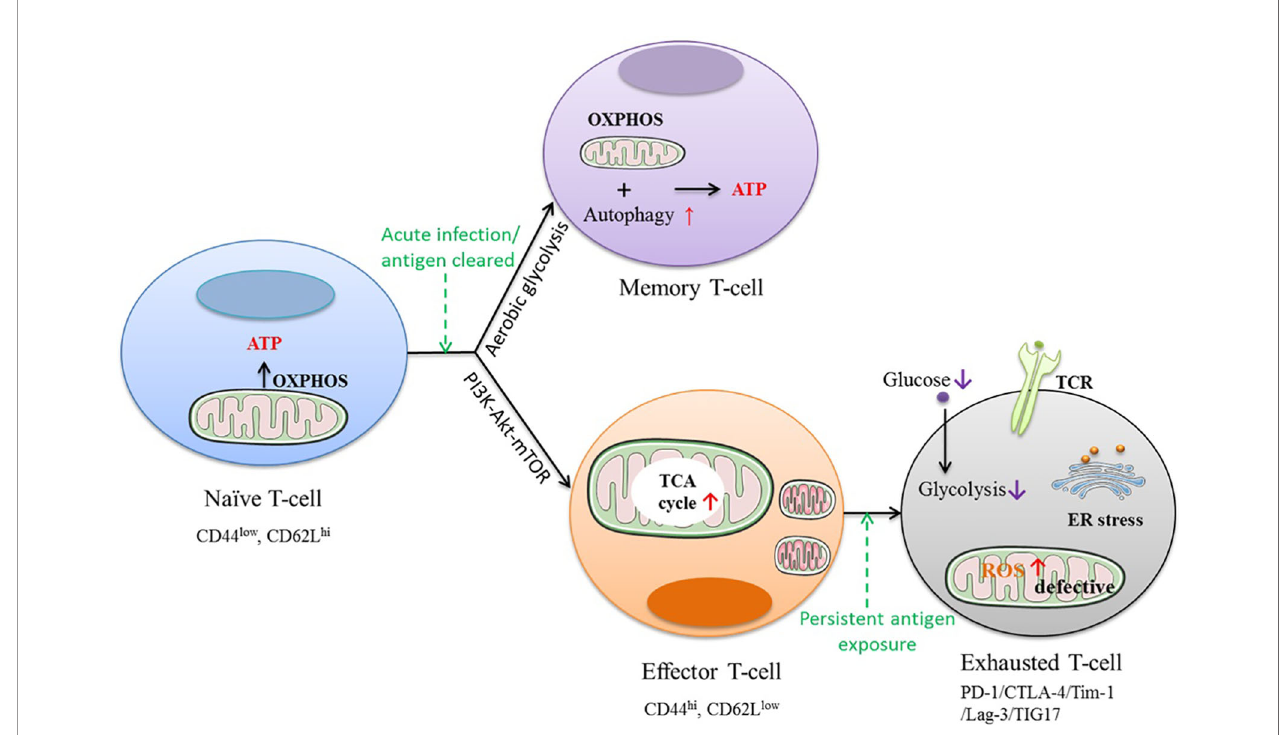
FIGURE 3 | The direct and indirect anti-tumor effects of